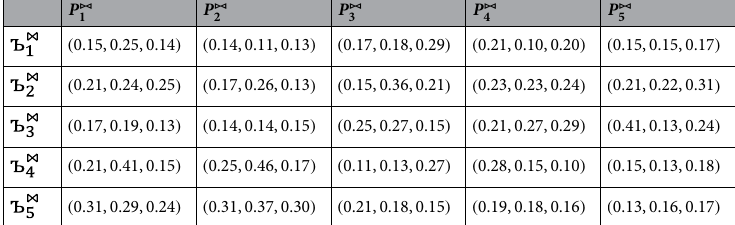
Table 3. Picture fuzzy soft data for F